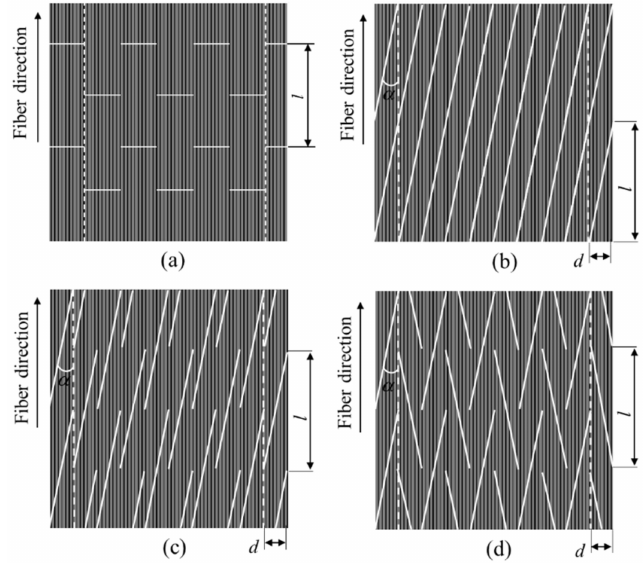
Figure 1. Existing types of slit patterns: ( a ) vertical slit [7], ( b ) continuous angled slit [8], ( c ) staggered- slit [10], ( d ) bi-angled slit